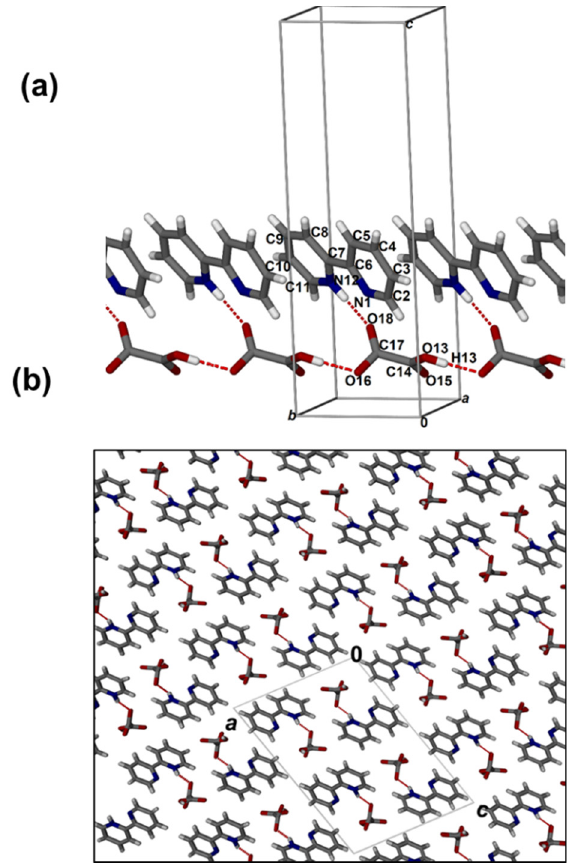
Figure 2. ( a ) A 1D chain of BPY H + ·OXA − formed by the interaction between BPY H + ·and OXA − and ( b ) the packing diagram of BPY H + ·OXA − viewed down the b axis. Table 1. Selected crystallographic data for BPY H + ·OXA − and BPY 2H + ·2MAL − .